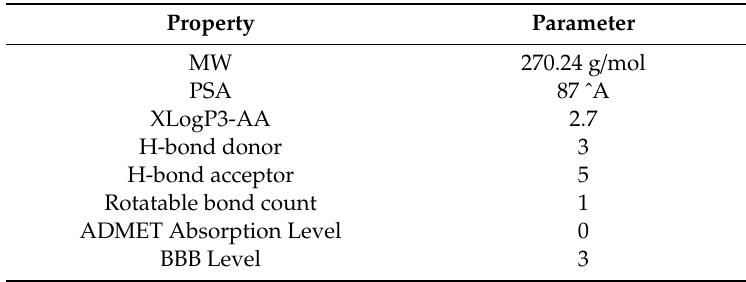
Table 1. Molecular properties of genistein.